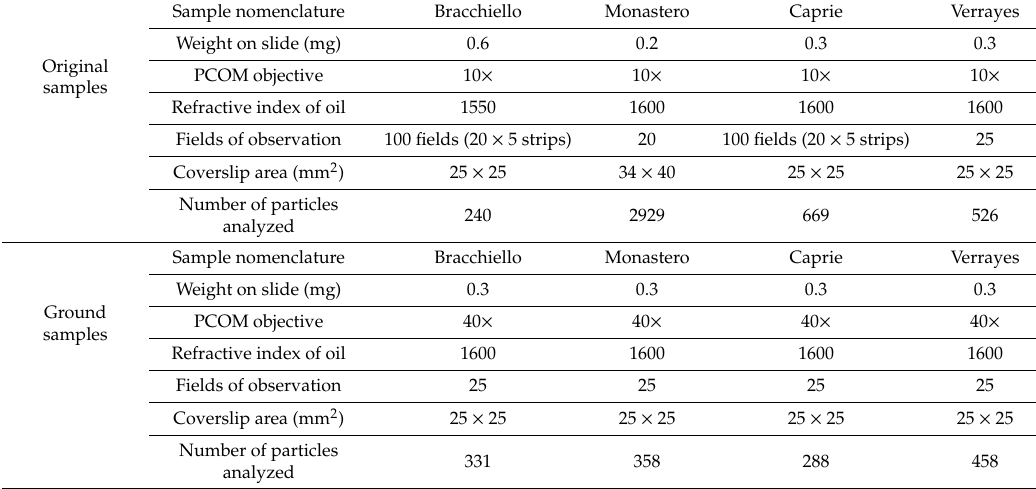
Table 4. Summarized information about original and ground